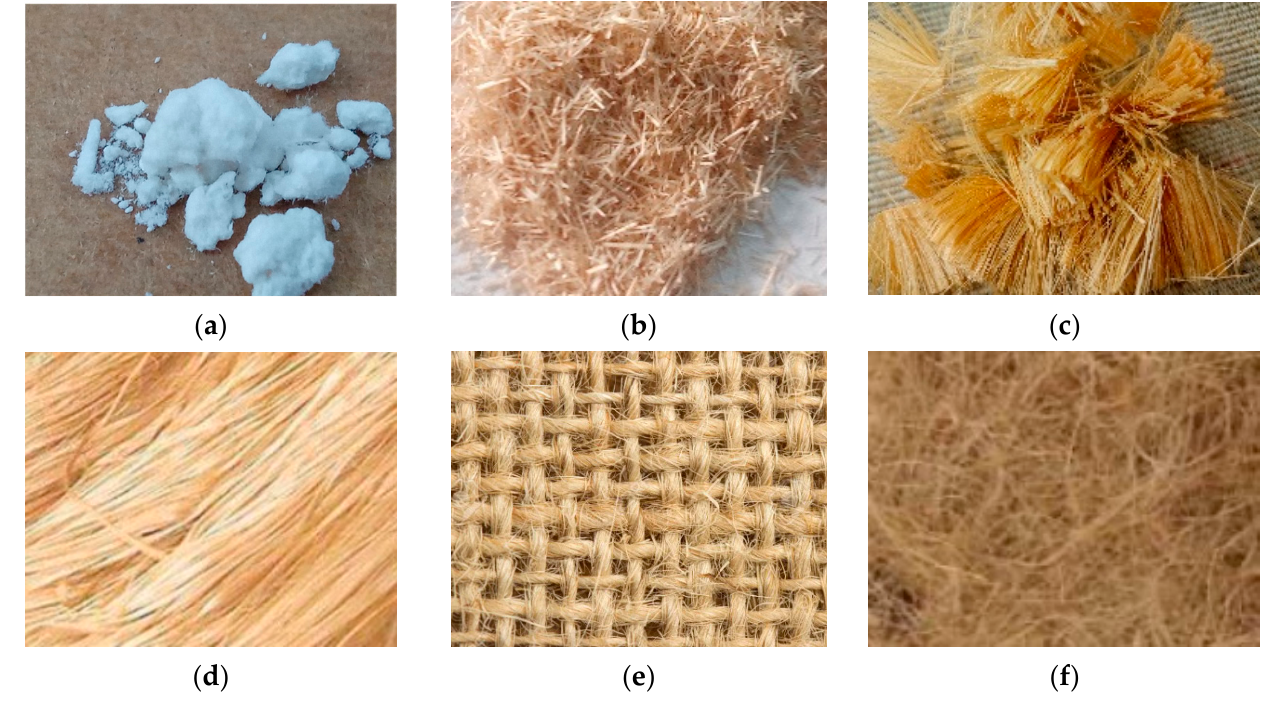
Figure 12. Different forms of jute fiber reinforcements used for fabricating polymer composite: ( a ) Particles, ( b ) Short ( c ) Semi-long ( d ) Long ( e ) Fabrics ( f ) Nonwoven.